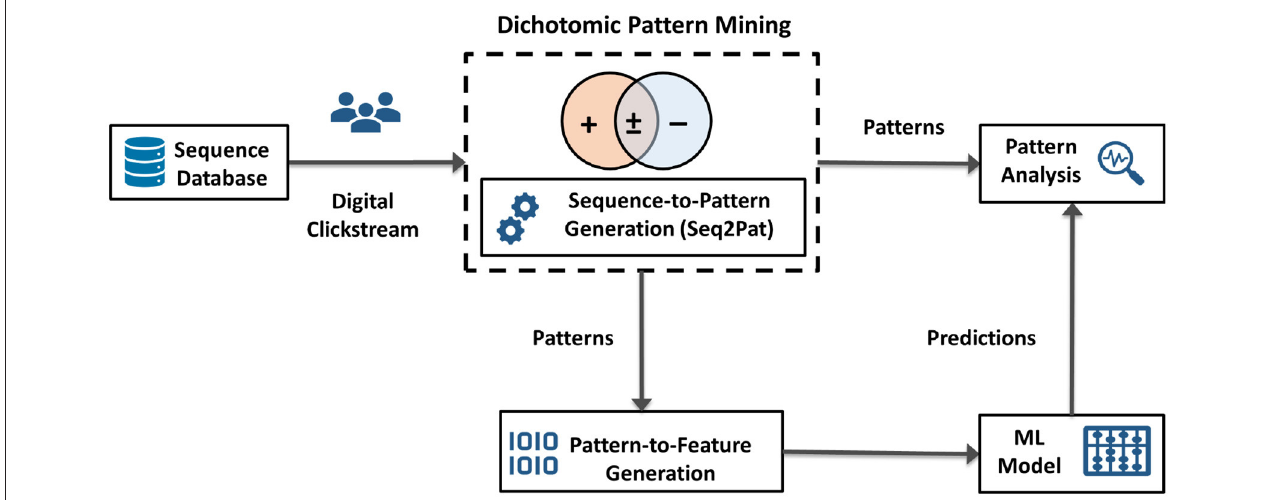
FIGURE 2 | High-level system architecture for dichotomic pattern mining, embedded with sequence-to-pattern generation, as an integration technology between raw sequential data, e.g., clickstream, pattern analysis, pattern-to-feature generation, and machine learning models for downstream prediction tasks.